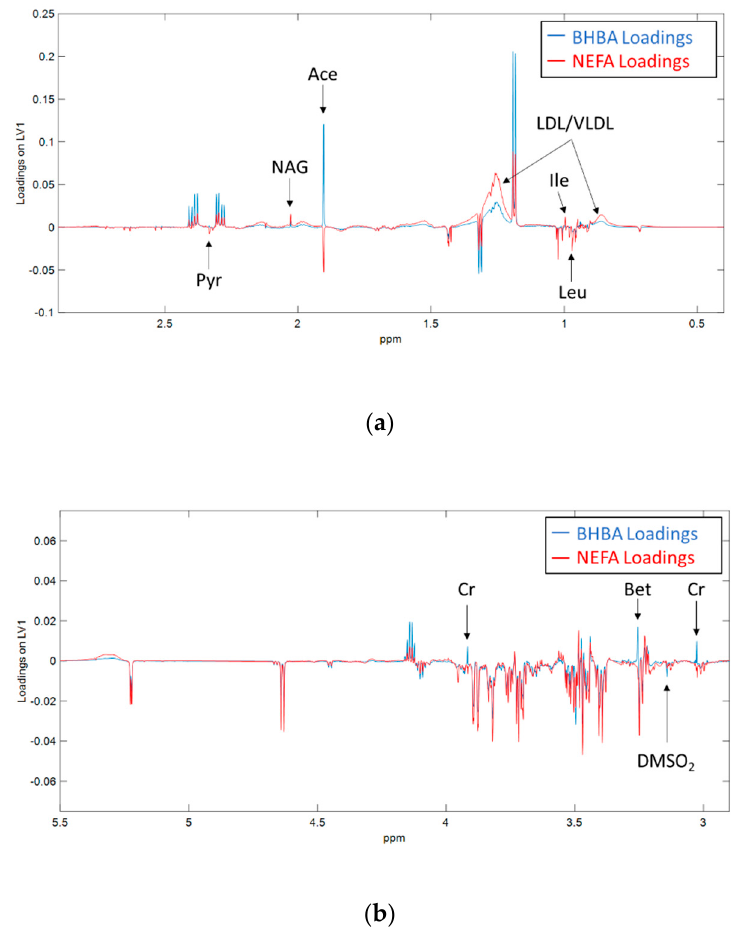
Figure 4. Loadings on the first latent variable (LV1) derived from orthogonal partial least squares (OPLS) regression of 1 H NMR spectra against serum BHBA (blue) and NEFA (red) concentrations in early lactation dairy cows. Spectral regions between ( a ) δ 0.2 ppm to 2.9 ppm and (b) δ 2.9 ppm to 5.5 ppm are shown. Figure ( b ) has been for clarity purposes. Ace = acetate, Bet = betaine, ChoP = Phosphocholine, Cr = creatine, DMSO 2 = dimethyl sulfone, Ile = isoleucine, Leu = leucine, LDL / VLDL = low / very low-density lipoprotein, NAG = N-acetyl glycoprotein, Pyr =